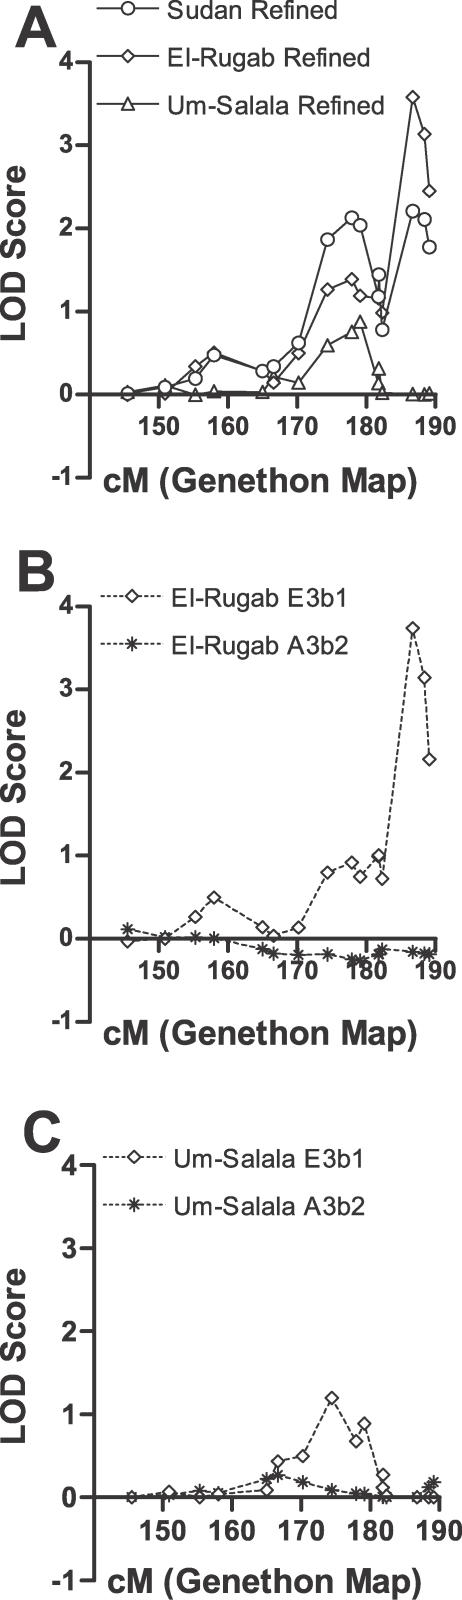
Genome Scan Data for Chromosome 6 for Multicase Families of Visceral Leishmaniasis from Sudan(A) refined mapping data by village; (B) data for El-Rugab village stratified by Y chromosome haplotype; (C) data for Um-Salala village stratified by Y chromosome haplotype. Multipoint LOD scores (plotted as sign(dhat)•LOD [36]) are shown on the vertical axis and the distance in cM (Genethon Map) from the p terminus on the horizontal axis. The mean ± SD peak LOD score at 6q27 obtained when randomly dropping one pedigree at each analysis (see legend to Figure 2) was 3.61 ± 0.46 (range 2.39–4.28). Information contents over the region of linkage at 6q27 (174–180 cM) were 0.66 ± 0.05 (range 0.61–0.72) for El-Rugab refined map in (A), 0.64 ± 0.07 (range 0.56–0.73) for El-Rugab E3b1 families in (B), and 0.87 ± 0.04 (range 0.83–0.94) for Um-Salala E3b1 families in (C).